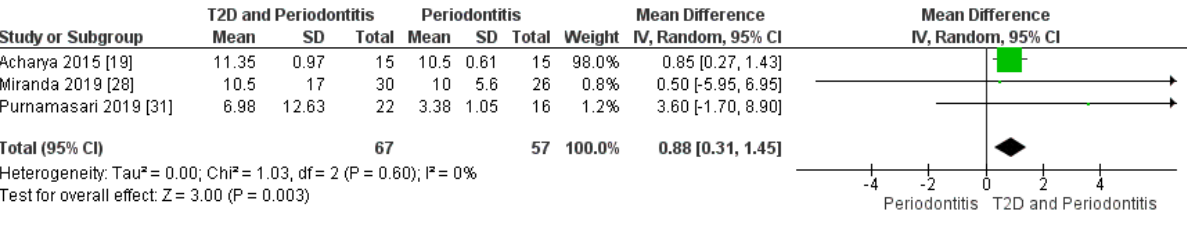
Figure 2. Forest plot for IL-10 levels in the plasma of the periodontitis and the diabetes plus periodontitis groups.